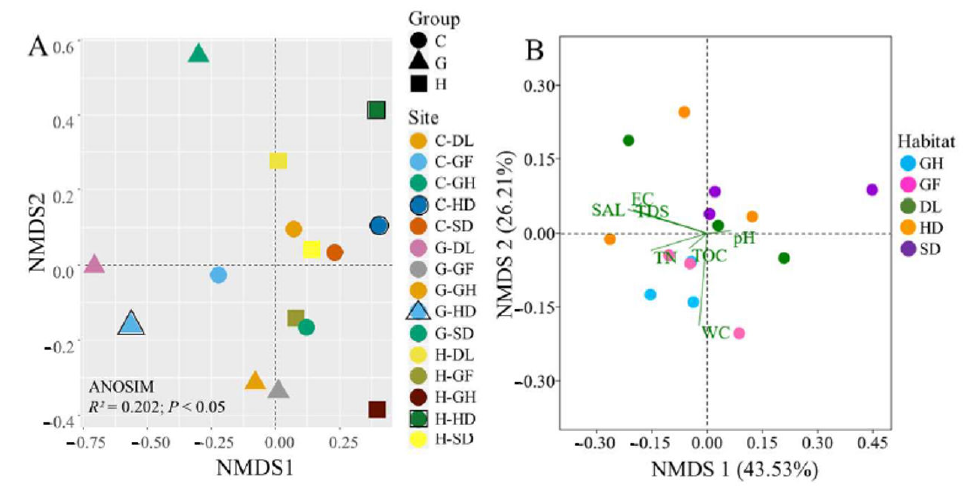
Figure 5. Bacterial communities of different habitats across three sites sampled from cold-desert, Qinghai–Tibet Plateau, China: ( A ) Non-metric multidimensional scaling (NMDS) of the Bray–Curtis- based dissimilarity matrix of bacterial community’s structure. Soil samples are divided into three groups (circle—C; triangle—G; rectangle—H). Analysis of similarities (ANOSIM) metric, a number indicating the degree of differences between the group (R 2 = 0.202; p < 0.05), for comparisons of bac- terial communities. ( B ) NMDS showing the correlation between responsive variables (environmental factors) and microbial taxonomic composition (explanatory variables) across different habitats. The green lines show the direction of the maximum change in soil variables (TN—total nitrogen; WC— water content; TOC—total organic carbon; SAL—salinity; TDS—total dissolved solid; EC—electric conductivity). First and second ordination axes were plotted, representing 43.53% and 26.21% of the variability in the data set, respectively. CNH—CuoNaHu, HLH—Hon gLiangHe,